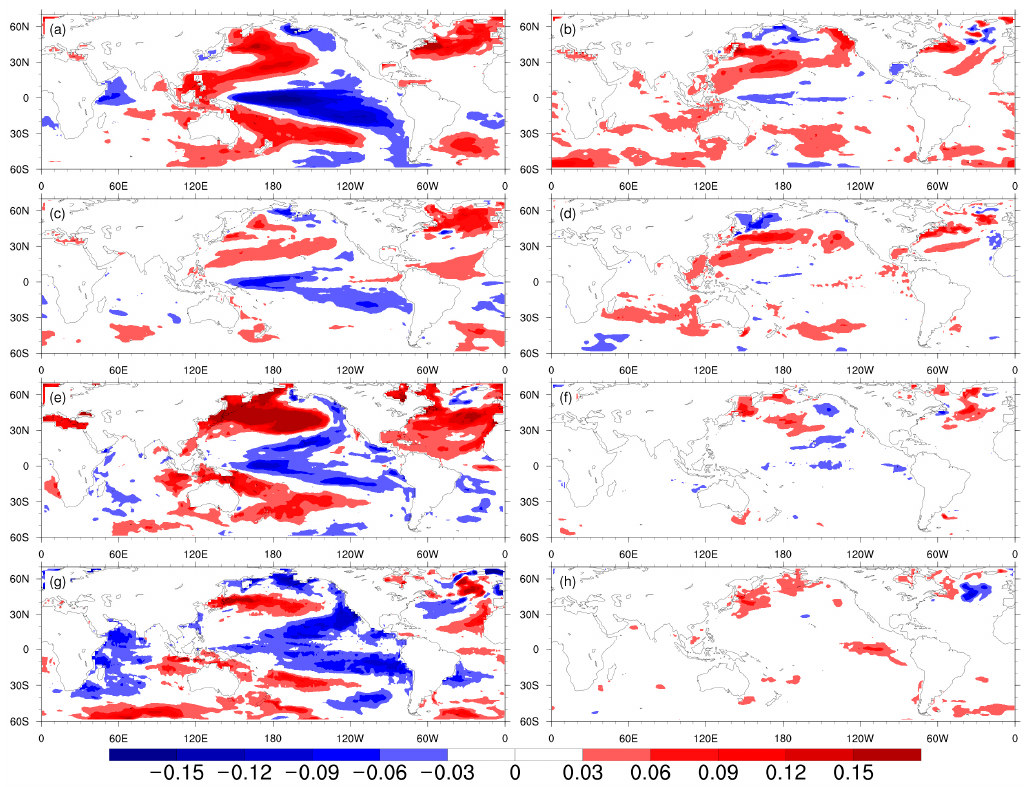
Figure 7. Averages of regressions of SST anomalies onto the first principle component from (left) good models and (right) poor models in ( a , b ) winter, ( c , d ) spring, ( e , f ) summer, and ( g , h ) autumn. Unit: degrees Celsius.